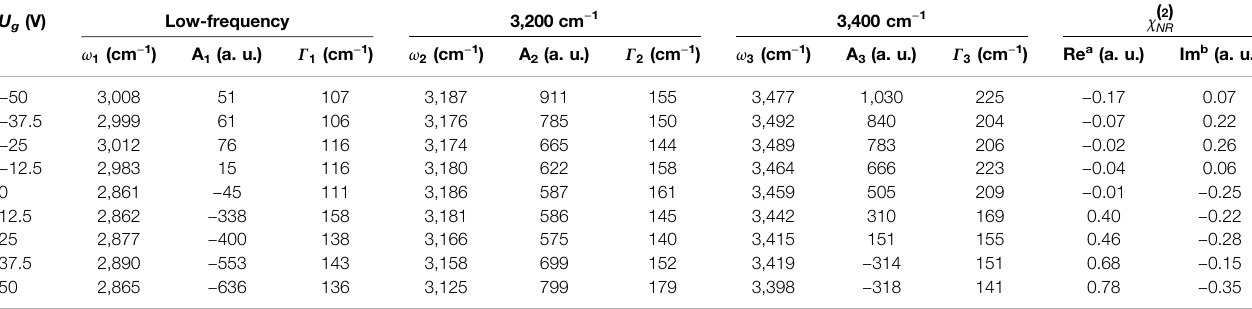
TABLE 1 | The fi tting parameters of the normalized SFVS spectra in H 2